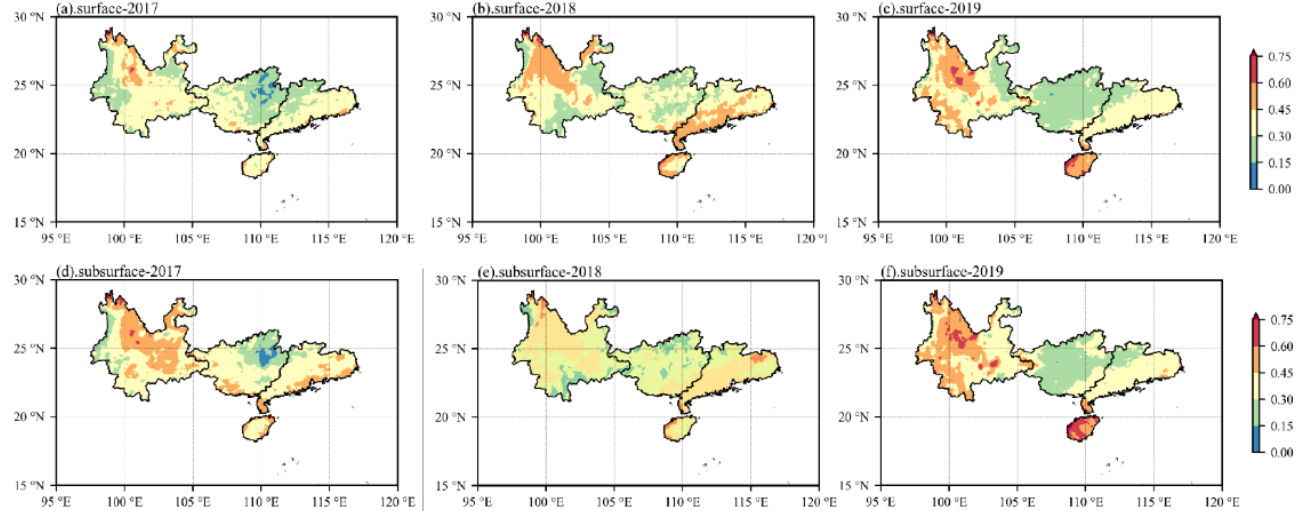
Figure 11. Spatial distribution of the PDW for the surface ( a – c ) and subsurface ( d – f ) in the four southern provinces of China during 2017 to 2019.